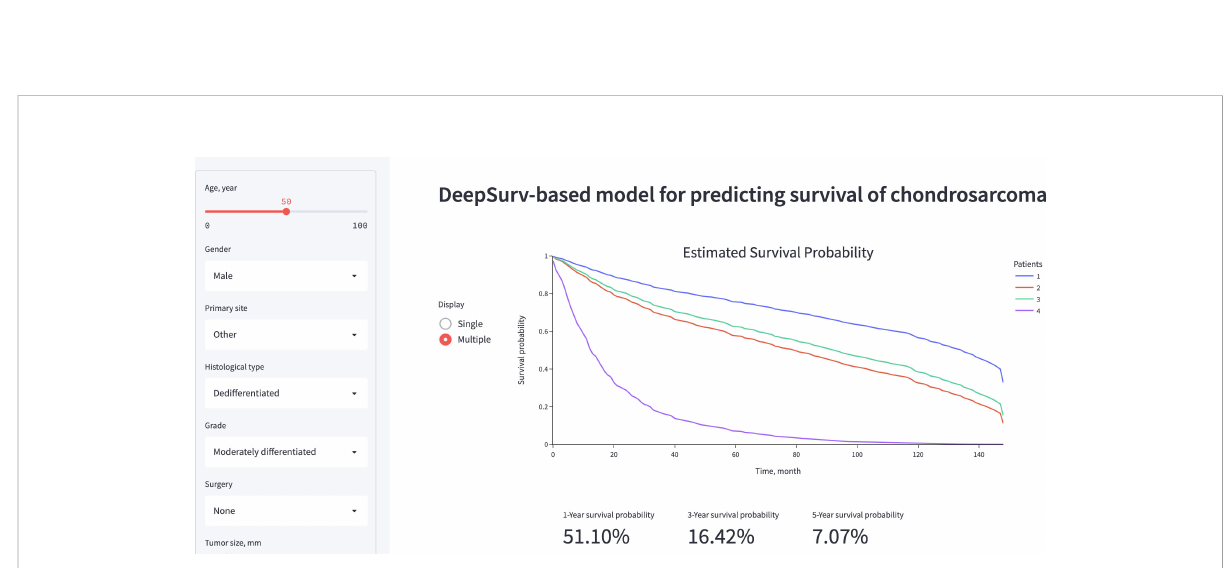
FIGURE 7 A screenshot of the online web-based application of DeepSurv